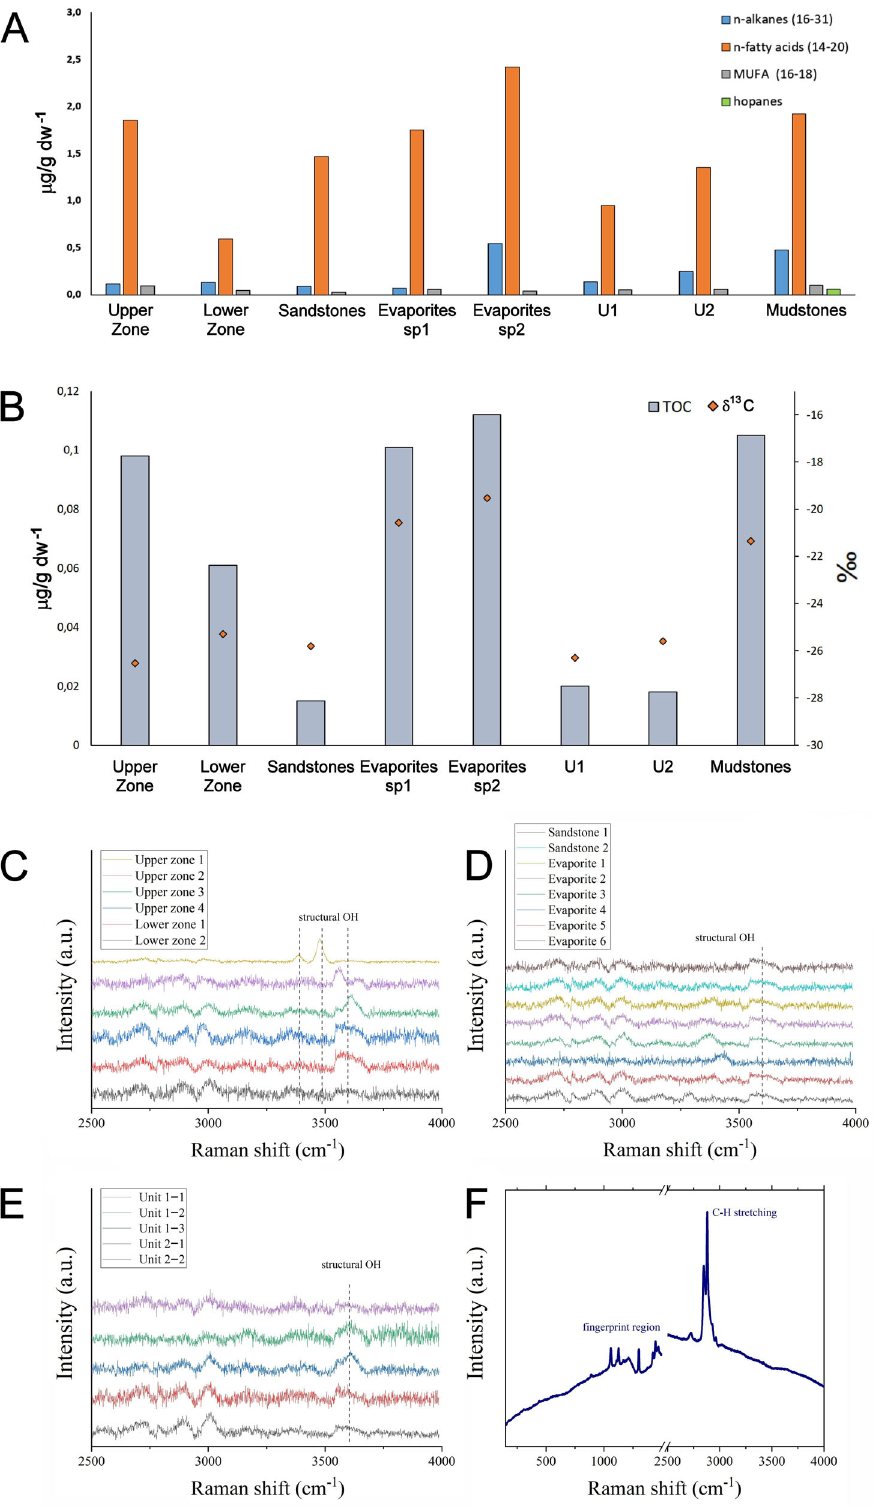
Fig. 5 | Lipid Biosignature analyses of Red Stone samples. A Lipid content, including normal (i.e. straight chain) alkanes, normal fatty acids, and mono- unsaturated fatty acids (MUFA) identi fi ed by gas-chromatography mass spectro- metry (GC-MS). Carbon numbers ranges are indicated in brackets. B Total organic